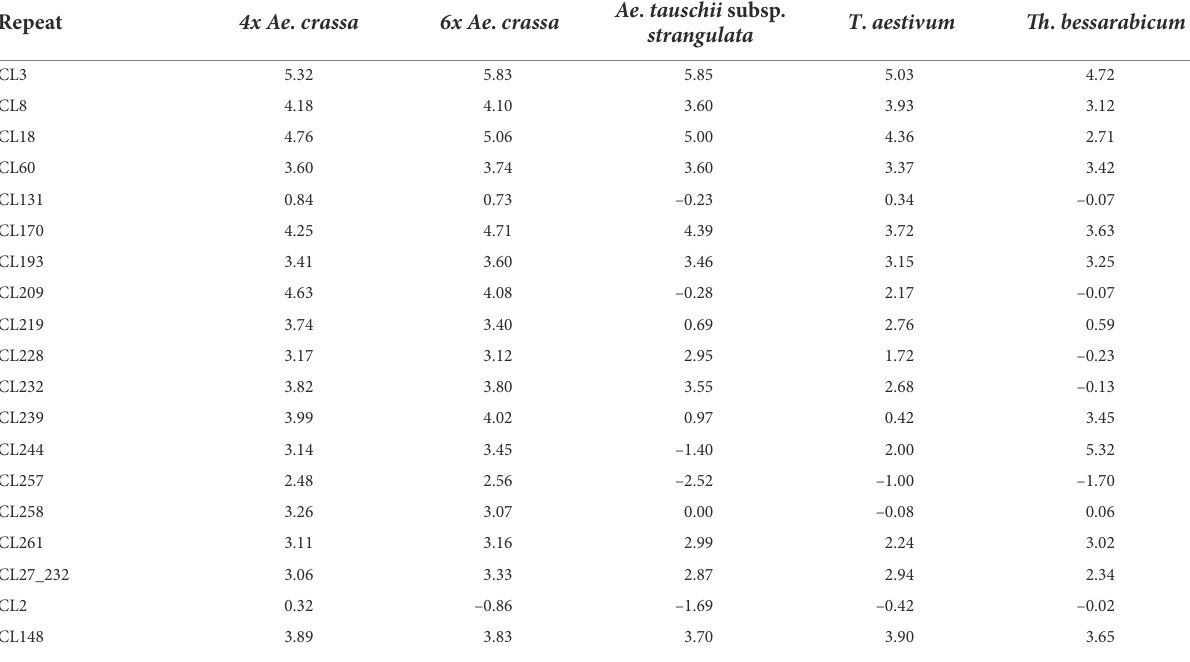
TABLE 3 Relative quantity (expressed in decimal logarithm) of the tandem repeats found in this study. Repeat 4x Ae. с